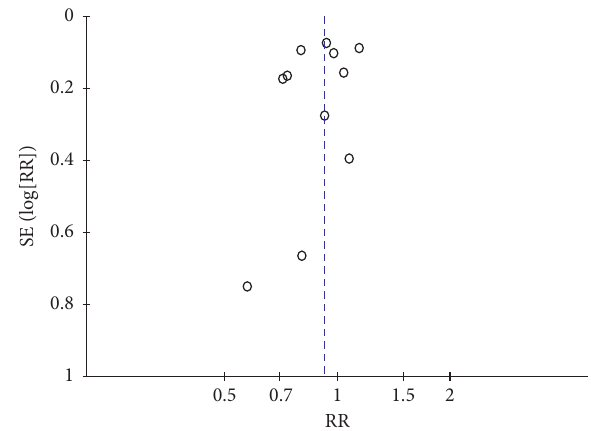
Figure 7: Funnel plot for all-cause